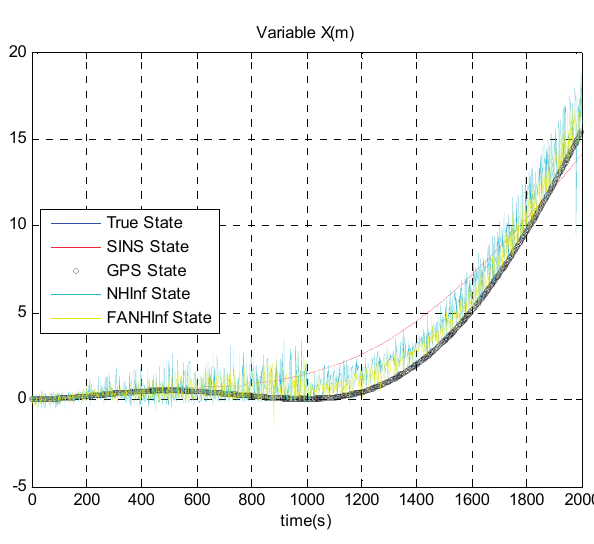
Figure 4. Estimation of the position X